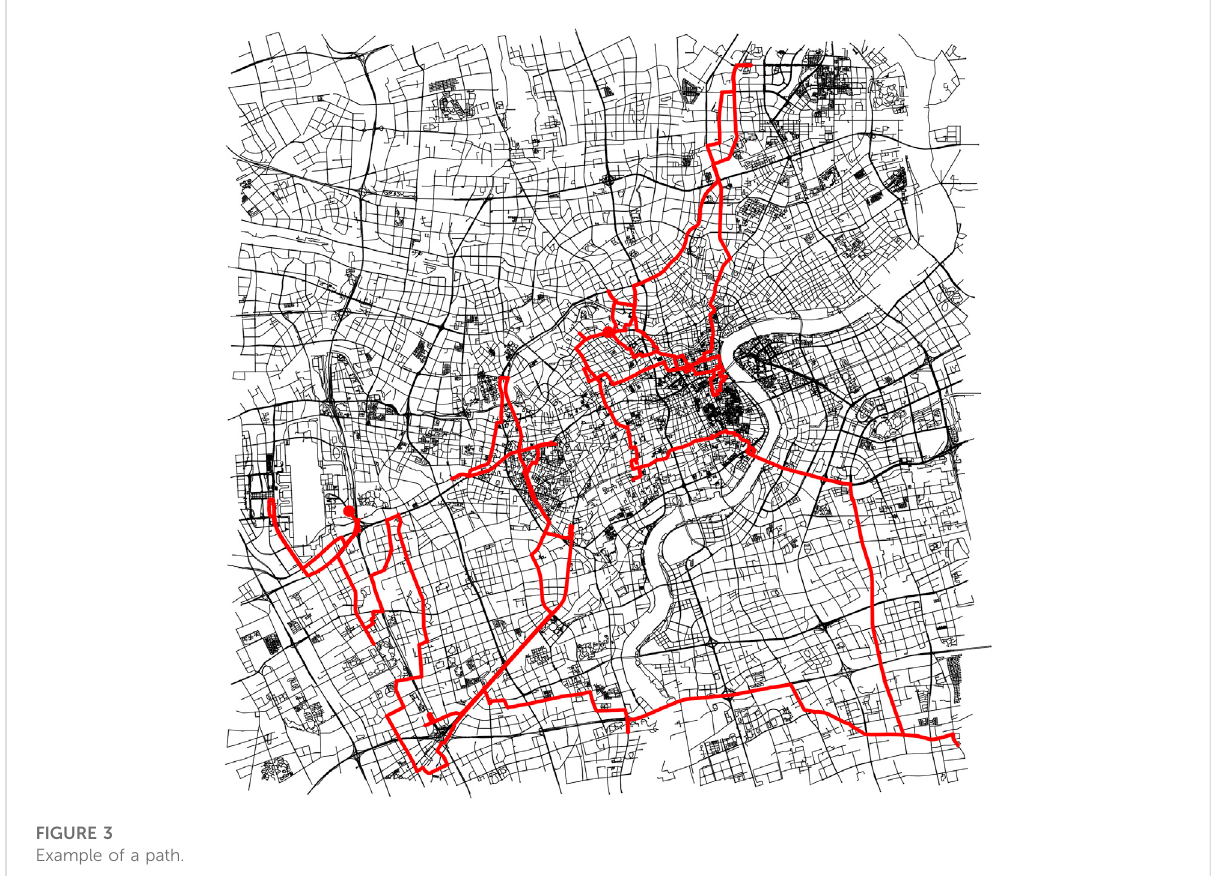
FIGURE 3 Example of a